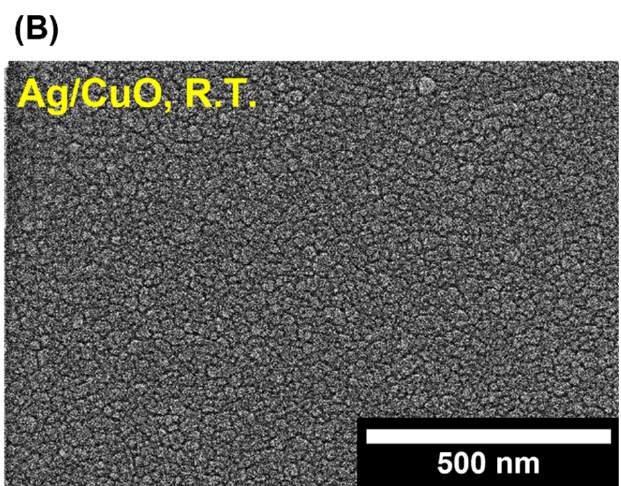
Figure 3. Electrical properties of CuO films with different postannealing temperatures obtained from Hall measurement: ( A ) carrier concentration; ( B ) resistivity; ( C ) mobility.